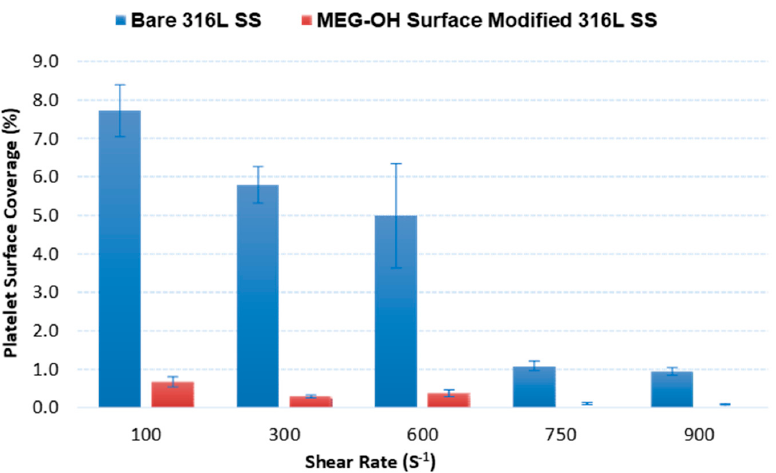
Figure 6. Percentage of surface coverage due to platelet adhesion on bare and MEG-OH modified 316L stainless steel after 20 min of blood perfusion at 100 s − 1 , 300 s − 1 , 600 s − 1 , 750 s − 1 , and 900 s − 1 shear rates. Table 3. Calculated Student’s t-values for comparison of mean platelet surface percentage cover- age on bare and MEG-OH-modified steel surfaces .